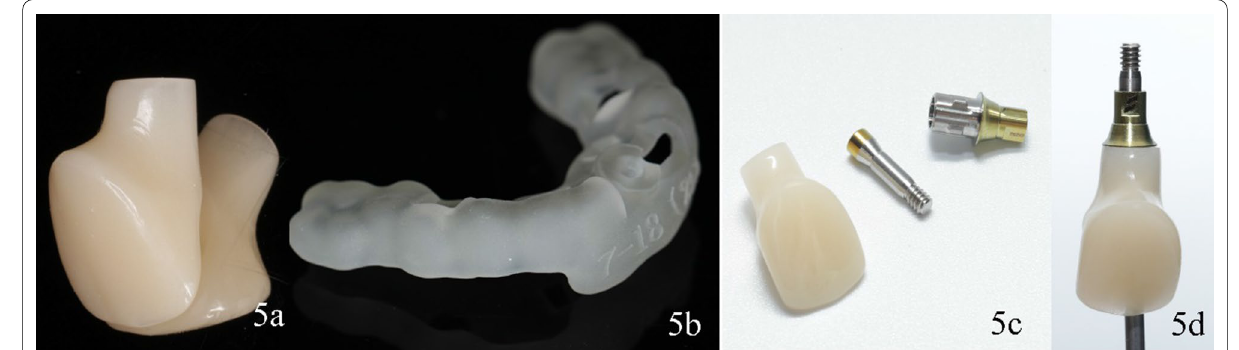
Fig. 5 Fabrication of interim restoration and surgical guide. a Interim restoration milled. b Surgical guide printed; cementation of interim restoration and abutment. c Interim restoration and abutment. d Bonding the center of the buccal side of the crown with facing the concave plane of the cross-fit structure of the